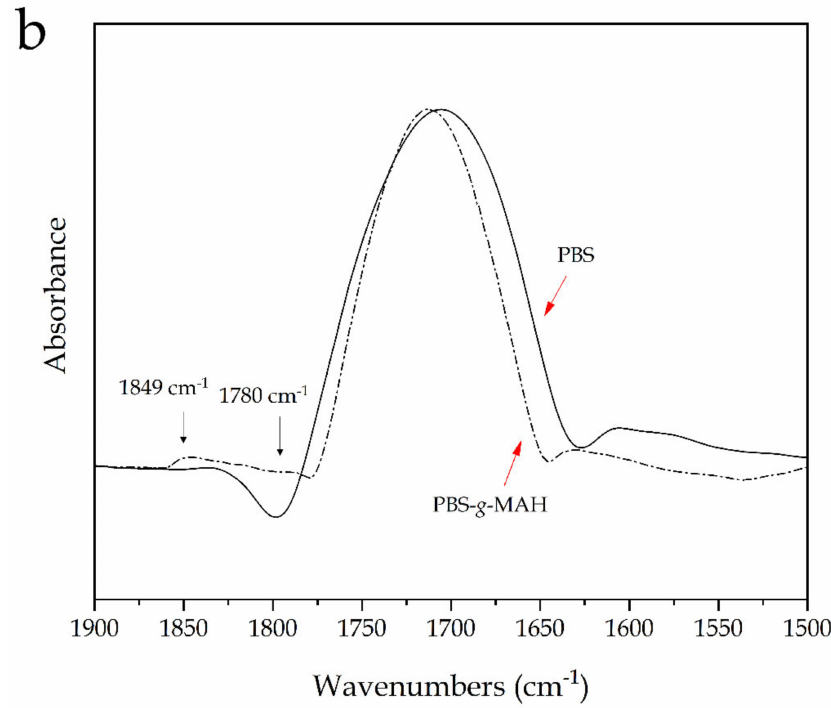
Figure 4. ( a ) Fourier transform infrared (FTIR) spectra, from bottom to top, of pistachio shell flour (PSF); poly(butylene succinate) grafted with maleic anhydride (PBS-g-MAH), poly(butylene succinate) (PBS), and PBS-5PSF, PBS-10PSF, PBS-20PSF, and PBS-30PSF green composites; ( b ) Detail